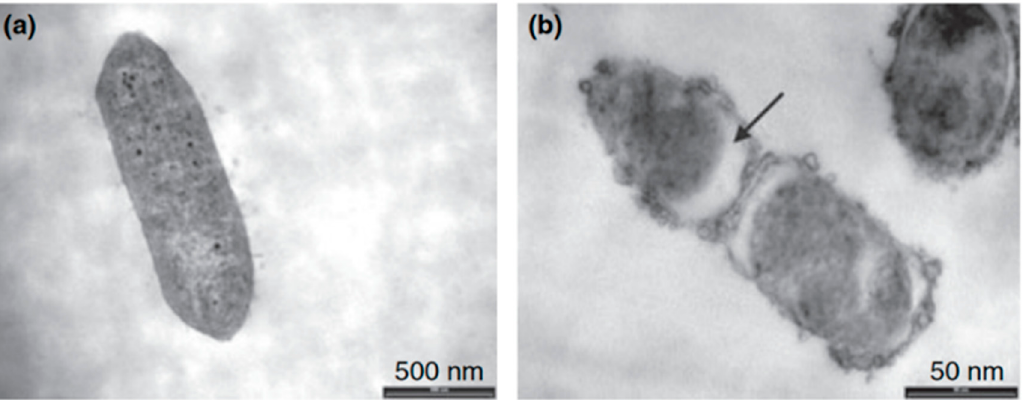
Figure 18. Transmission electron microscopy ( a ) Pseudomonas aeruginosa strain 6294; ( b ) P. aeruginosa Scheme 6294. exposed to melimine. Reproduced from [84]. © 2008 Willcox et al. J. Appl. Microbiol. © 2008 The Society for Applied Microbiology.